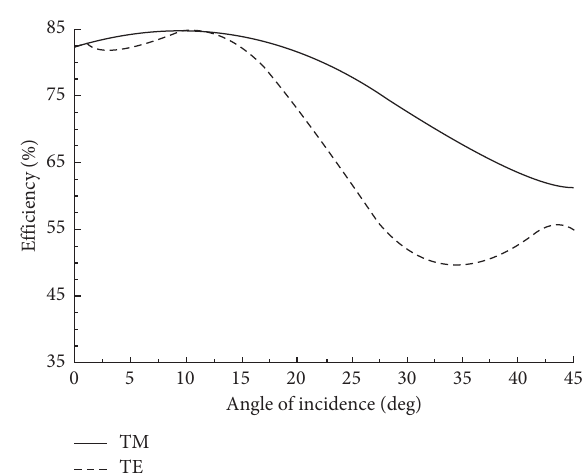
Figure 5: Integrated absorption efficiency (AE optimized CNV nanoantenna [7].